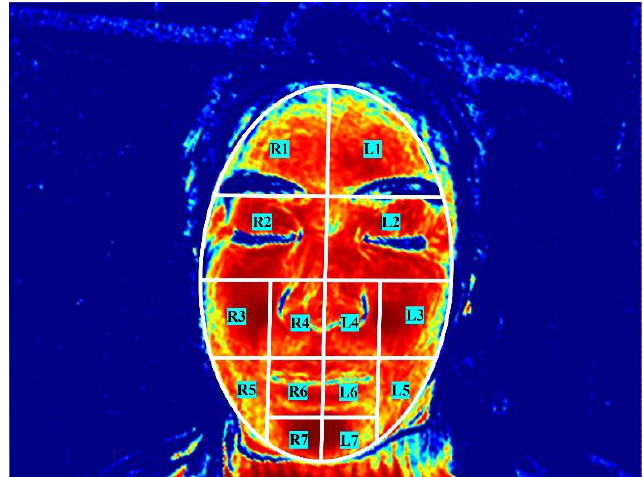
Figure 2. The facial regions of interest. L, left; R, right. (The written informed consent from the individual for the publication of the image was submit ted as Supplementary